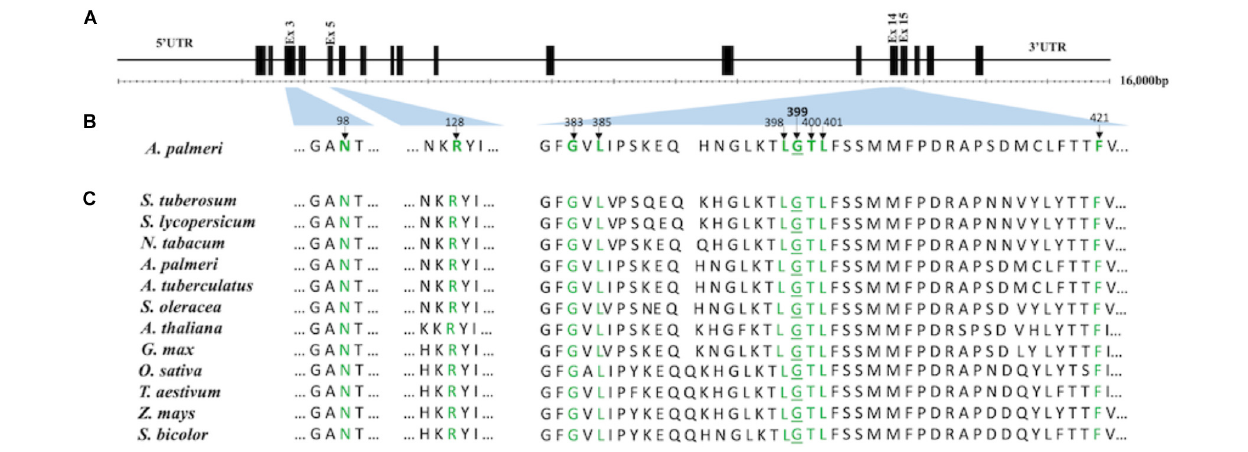
Frontiers in Plant Science |